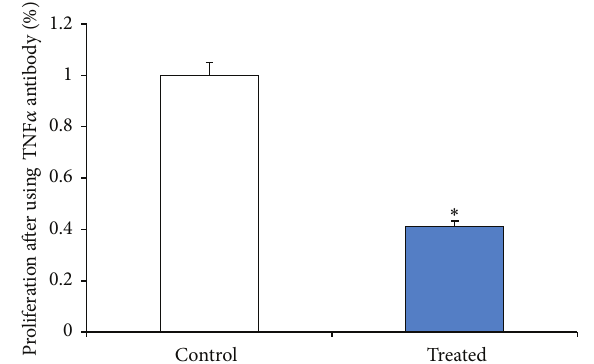
Figure 5: Effects of anti-TNF 𝛼 neutralizing antibodies on EGE cell proliferation. Conditioned media collected from SW872 cells grown to more than 80 percent confluence were centrifuged, filtered, and diluted to 1%. These conditioned media were treated with 1ng/mL of anti-TNF 𝛼 antibody for an hour at 37 ∘ C. The neutralized conditioned media were then added to EGE cells and cell proliferation measured using CyQuant assay. Results shown represent three separate experiments with comparable results. ∗ 𝑃 < 0.05 (mean ± SE; 𝑛 = 3 ).